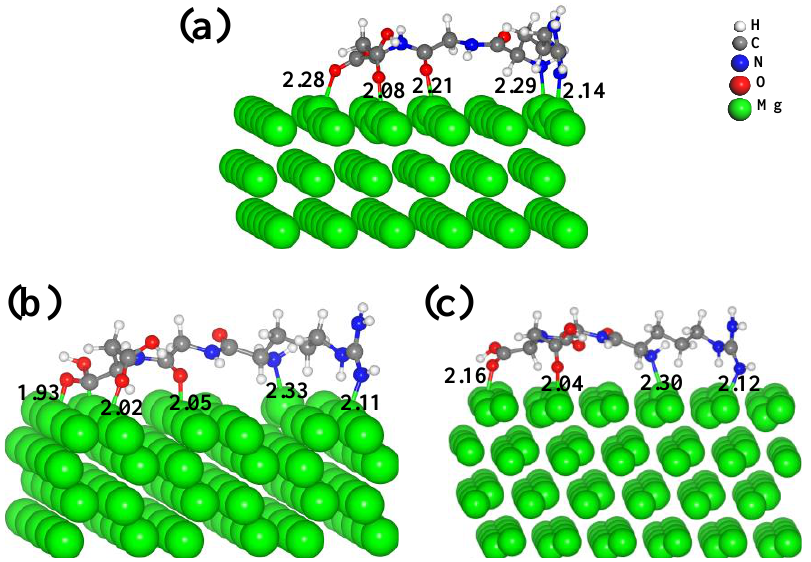
Figure 3. Stable adsorption configurations of RGD on the surfaces: ( a ) Mg(0001), ( b ) Mg(11 2 0) and ( c ) Mg(10 1 1).